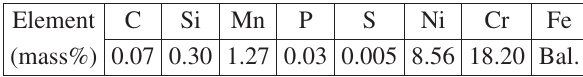
Table 1. Sample composition.